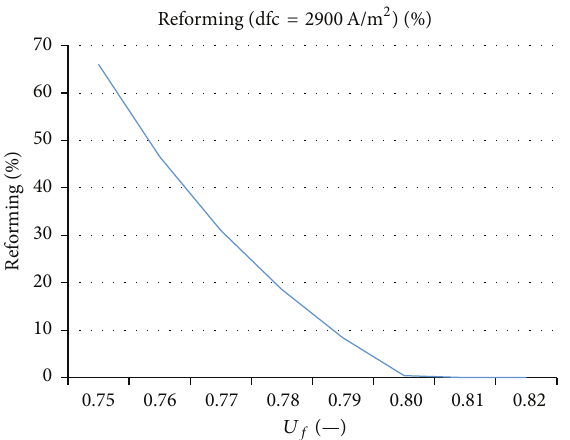
Figure 8: Turbogas power at varying 𝑈 𝑓 .